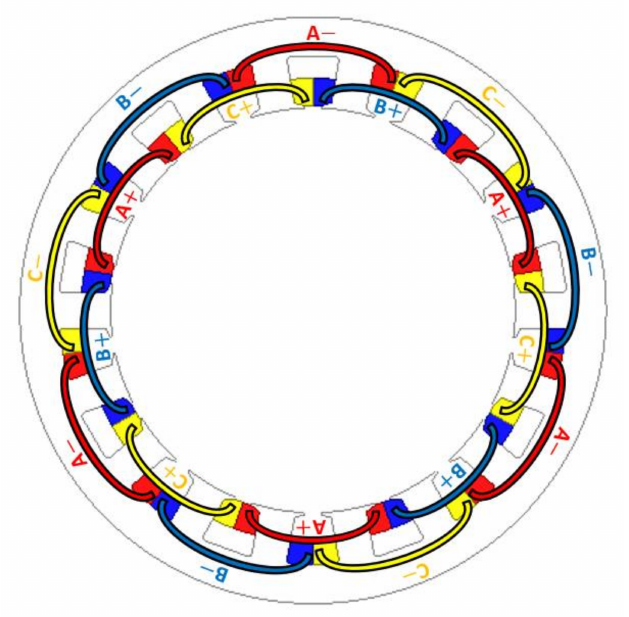
Figure 8. Final winding layout for 2x9S/6P